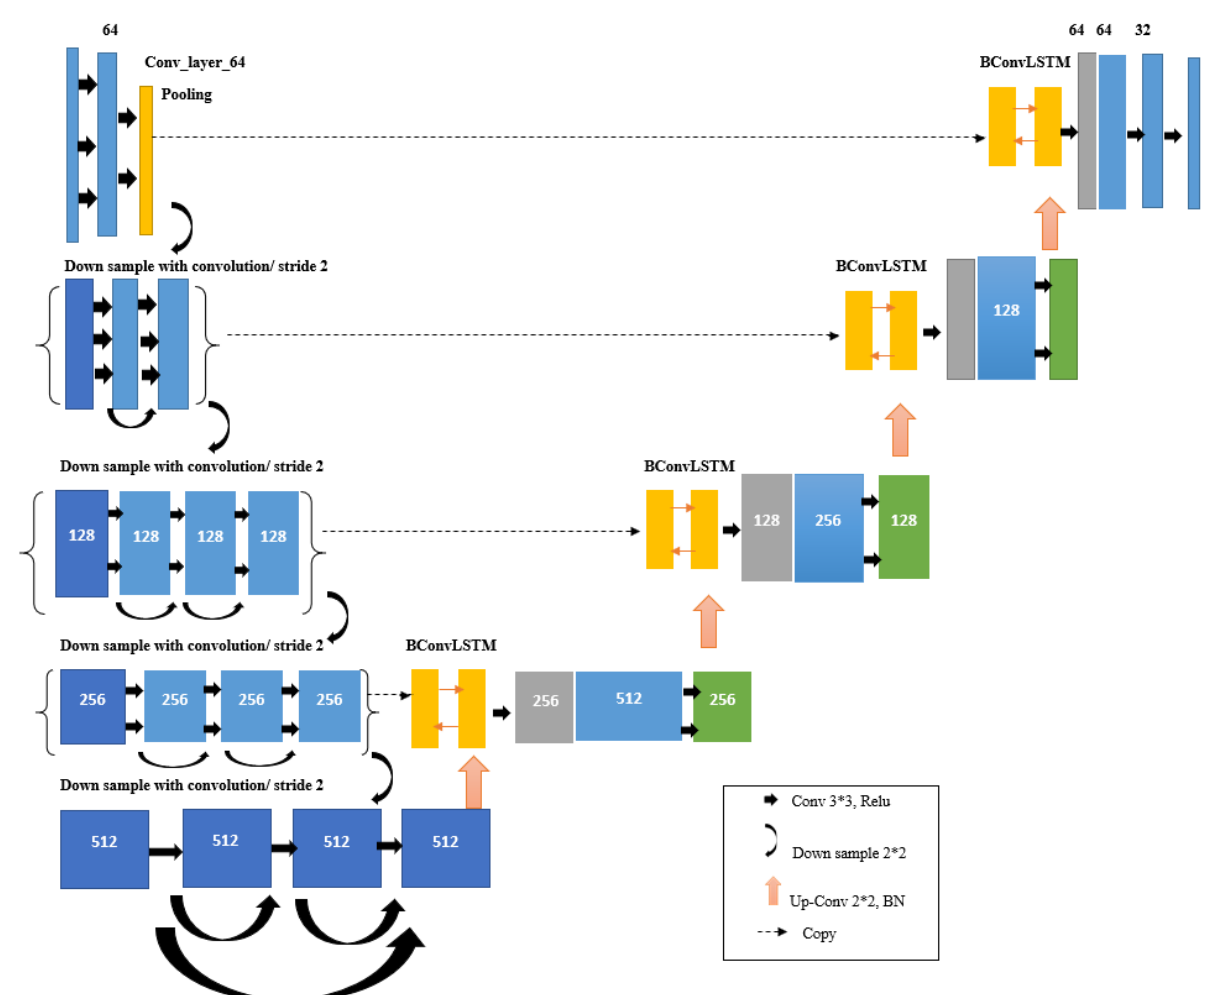
Figure 14. Res BCDU-Net architecture. The contraction path consists of Res blocks and a max-pooling layer. Such the U-Net, in each downsampling of encoding path, feature channels are doubled (64 to 128 to 256 to 512). In the last layer of the contracting path, we used 3 convolutional blocks with 2 dense connections. As seen, in the expansion path, the output of each batch normalized is given to a BConvLSTM layer.